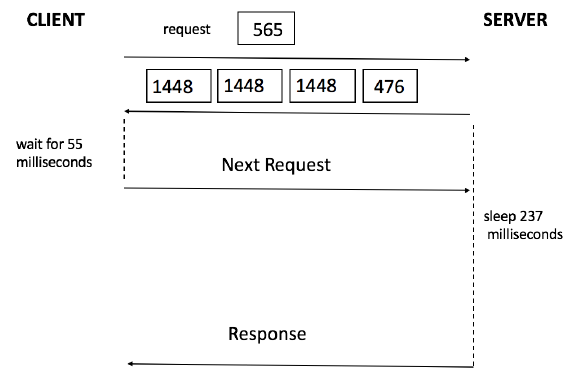
Figure 4. An example of the algorithm, train 4 is selected from T S out and train 8 is selected from T S in